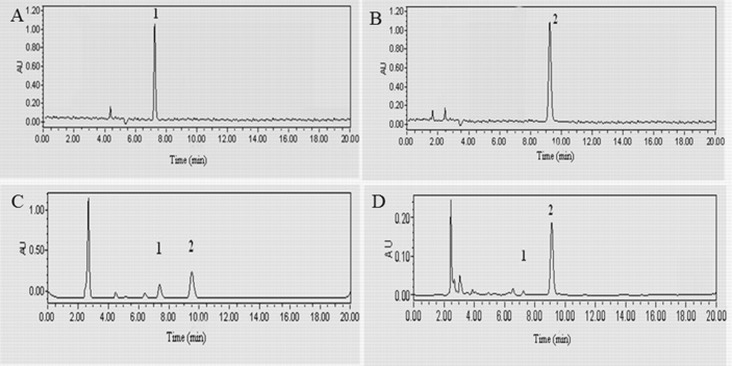
HPLC chromatograms.(A) 1-hydroxymidazolam, (B) midazolam, (C) microsomes spiked with midazolam for incubation, (D) plasma sample obtained from rat after intravenous midazolam injection; 1, 1-hydroxymidazolam; 2, midazolam.